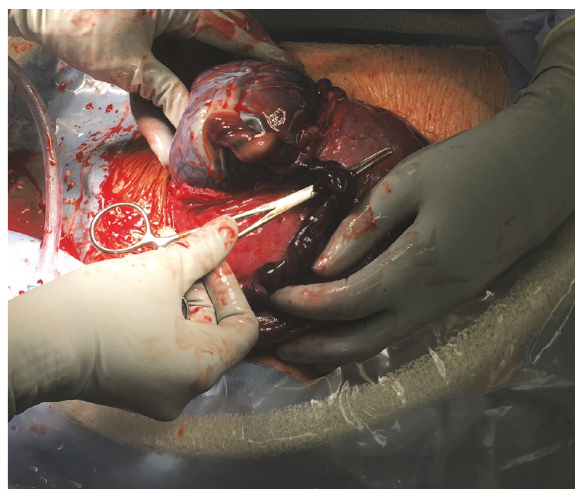
Figure 1: Gross umbilical cord at time of delivery.